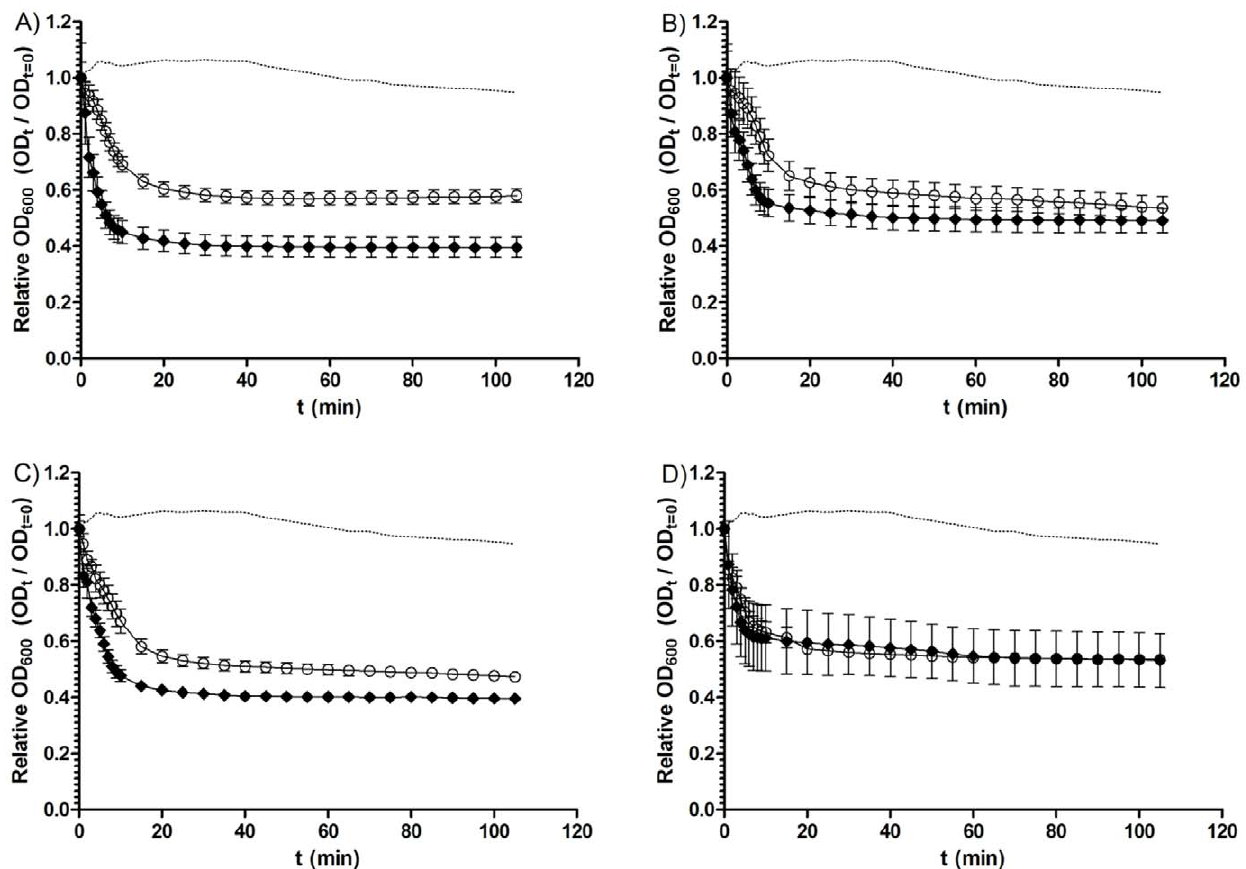
Figure 4. Loss of spore OD 600 of four C.difficile isolates during incubation with different concentrations of taurocholate. C. difficile N spores were heat treated at 60 u C for 25 min and then incubated in BHIS supplemented with either 0.1% (w/v) taurocholate ( # ) or 1% (w/v) ) for 2 h. A) CDC38; B) 7004578; C) 5108111; D) CD2315. The data represent the average of three independent experiments and error taurocholate ( bars indicate the standard errors of the means. The dotted line represents the negative control strain (DH361) during incubation with both 0.1% (w/v) taurocholate and 2 mM chenodeoxycholate (a strain found, in preliminary studies, not to germinate when exposed to chenodeoxycholate).